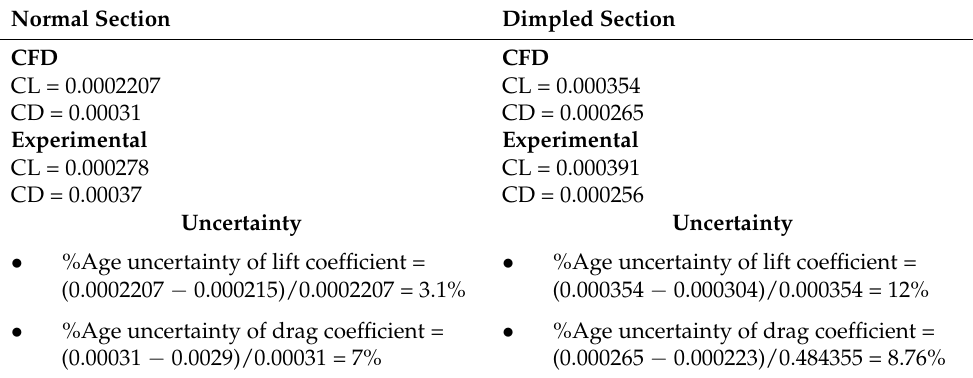
Table 6. Uncertainty calculation of both the geometries of the bullet